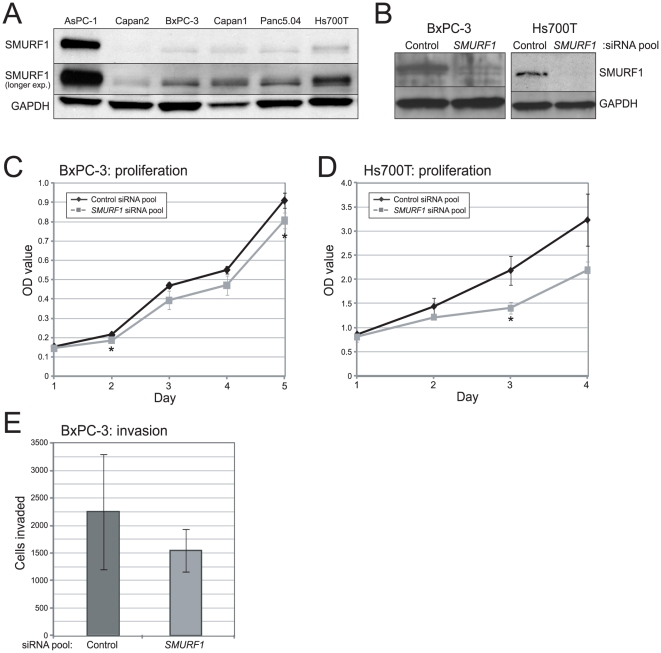
Analysis of SMURF1 knockdown in other pancreatic cancer lines.(A) Western blot analysis of endogenous SMURF1 protein levels in a panel of pancreatic cancer cell lines. Note that SMURF1 is highly expressed only in the 7q22.1-amplified AsPC-1 cell line. Two different exposures of the SMURF1 blot are shown; GAPDH serves as a loading control. (B) Western blot verification of SMURF1 knockdown (by SMURF1-targeting siRNA pool, compared to non-targeting control siRNA pool) in BxPC-3 and Hs700T cells. (C) Cell proliferation/viability assayed (by WST-1) in BxPC-3 cells following SMURF1 siRNA-mediated knockdown (compared to non-targeting control). Assay done in triplicate (mean +/− 1SD shown); *, P<0.05 (Student's t-test). (D) Cell proliferation/viability assayed in Hs700T cells, as above. (E) Cell invasion assayed (by Boyden chamber) in BxPC-3 cells following SMURF1 knockdown (compared to non-targeting control). Assay done in triplicate (mean +/− 1SD shown). Note, the reduced proliferation observed with SMURF1 knockdown in Hs700T cells precluded an assay of cell invasion (where invaded cell numbers at 72 hrs are influenced by doubling times).